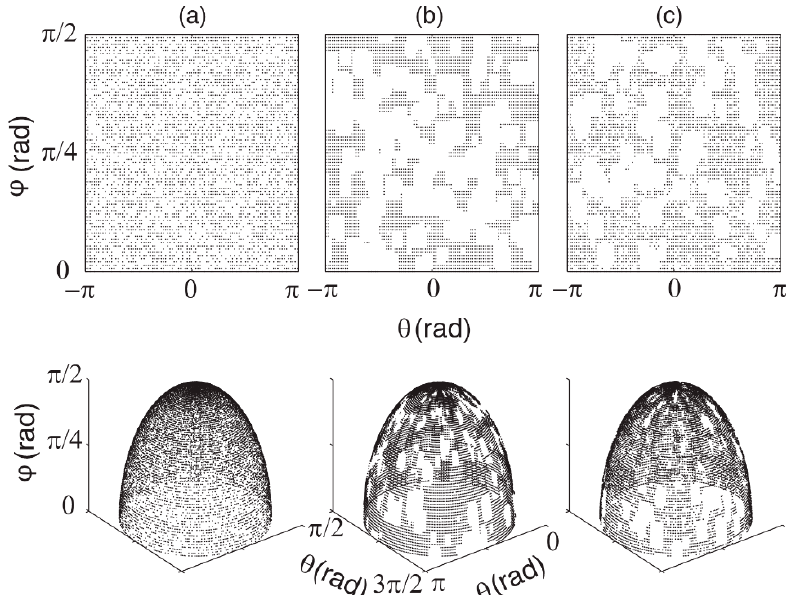
Figure 3. Simulated angular data (top) and hemispheric 3D view (bottom) with R ( a ), C ( b ) and RC ( c ) gap patterns and 0.5 GF. The θ range of the top image was constricted for better visualization of the gap patterns.